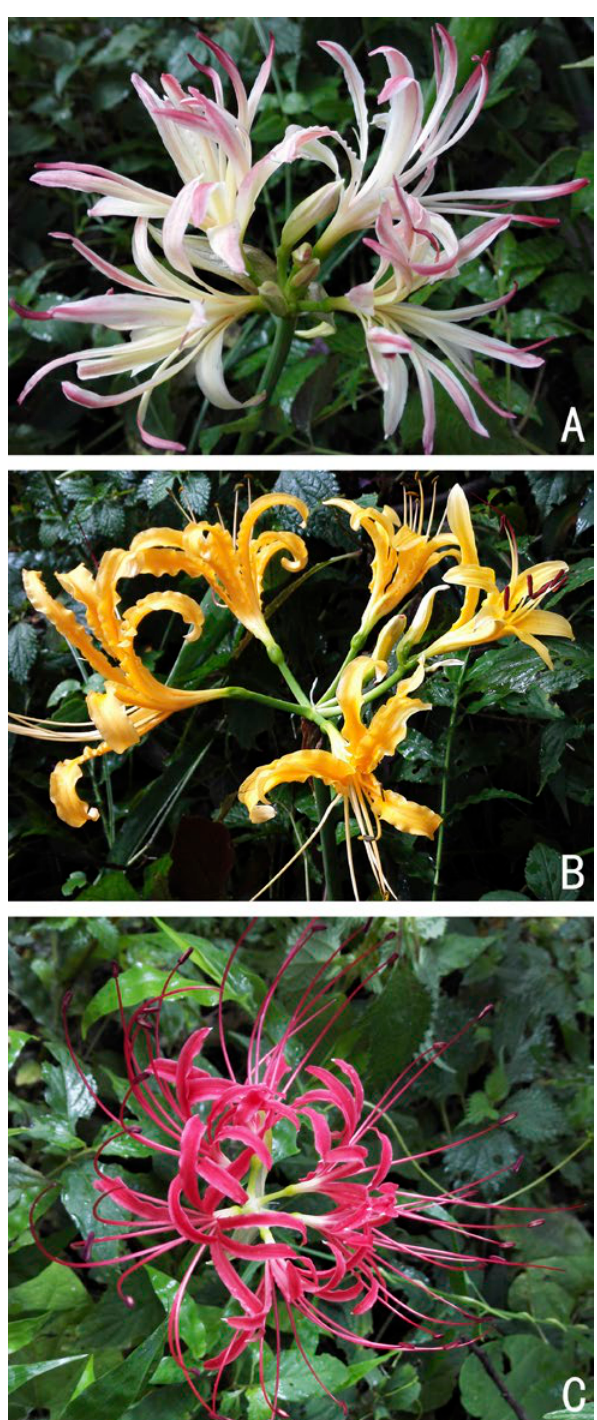
Fig 1. The flowers of the three taxa. A: the putative natural hybrid; B: L . aurea ; C: L . radiata